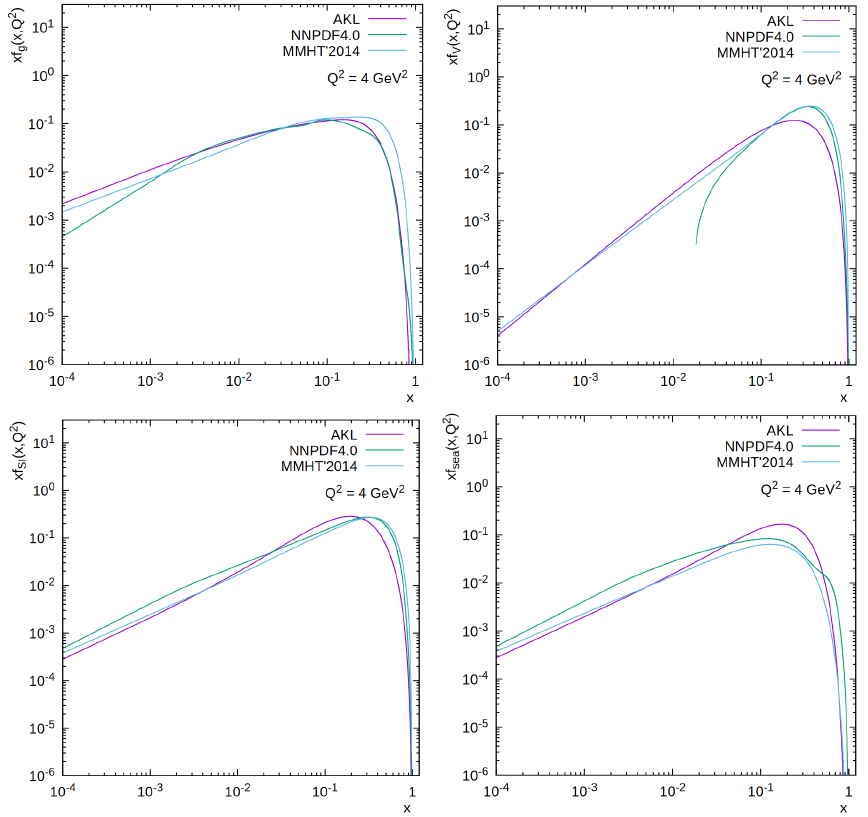
Figure 1. The gluon, valence, singlet and sea quarks densities in the proton calculated as a function of the longitudinal momentum fraction x at hard scale Q 2 = 4 GeV 2 . The purple curve corresponds to the results obtained with AKL, the green and blue curves with NNPDF4.0 (LO) and MMHT’2014 (LO) parton density functions,